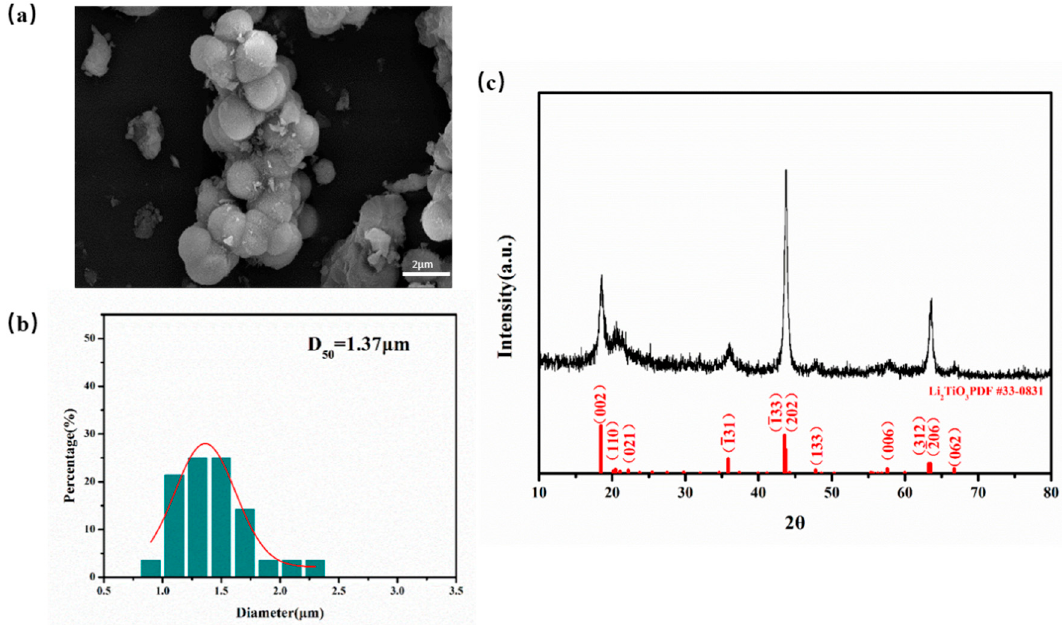
Figure 2. Li 2 TiO 3 micro-powders prepared by sol-gel-hydrothermal method: ( a ) SEM image; ( b ) par- ticle size distribution histogram; ( c ) XRD pattern. ticle size distribution histogram; ( c ) XRD